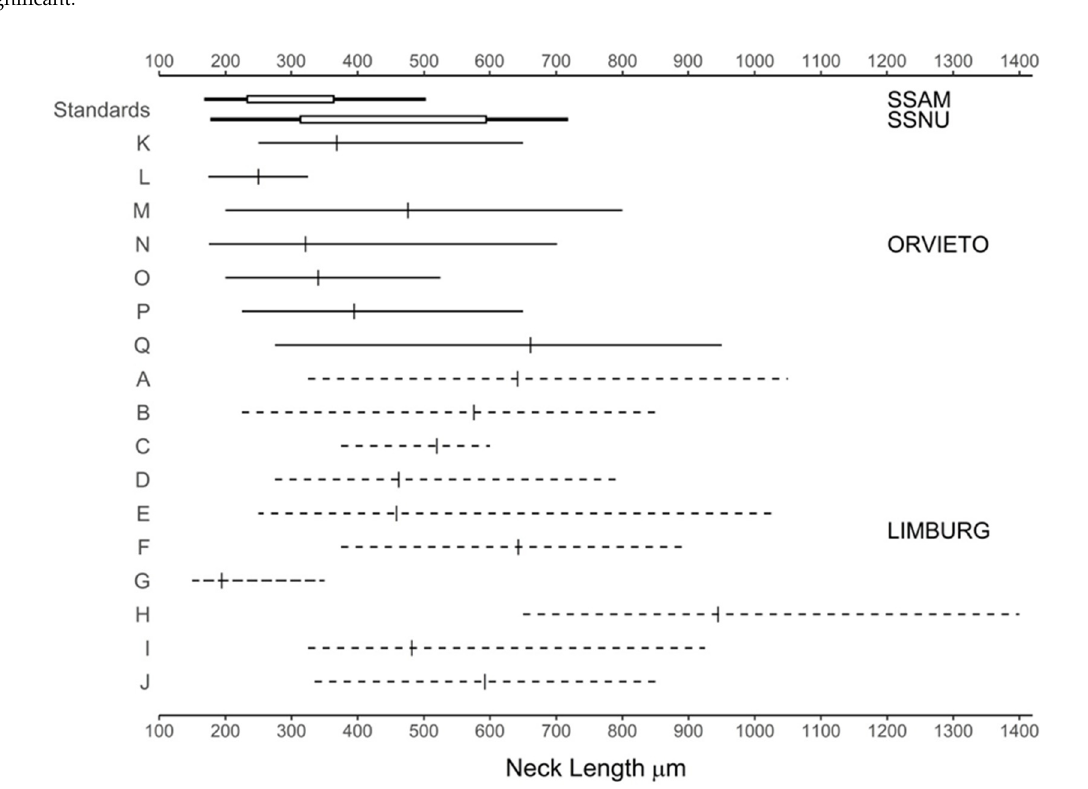
Figure 4. Comparative perithecial neck lengths of the Orvieto and Limburg hybrids and of the parental O. novo-ulmi subspecies. Above, SSAM and SSNU standards: published neck length ranges (thicker horizontal lines) and range of means (narrow horizontal boxes) for the two subspecies [24], based on pairings of 14 SSAM and 16 SSNU isolates from across Eurasia and North America. Middle and bottom, means and ranges for the seven pairings, K to G, within the Orvieto hybrid population and the ten pairings, A to J, within the Limburg hybrid population. Solid (Orvieto) and dashed (Limburg) horizontal lines, sample ranges. Short vertical bars, sample means. Details of isolate pairings in Section